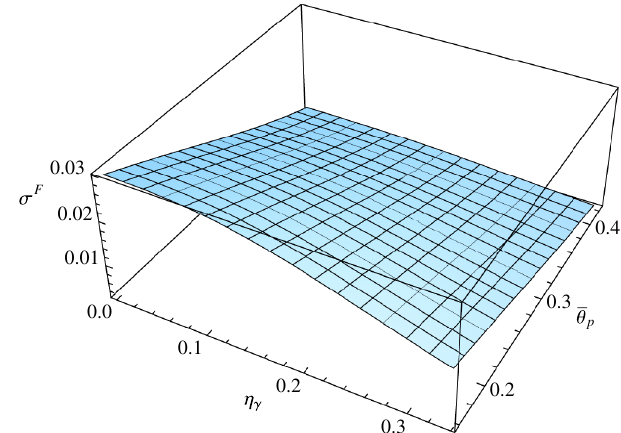
FIG. 5. Analytic fit contour and simulated data points for ¼ 0 . (cid:5) (cid:3)